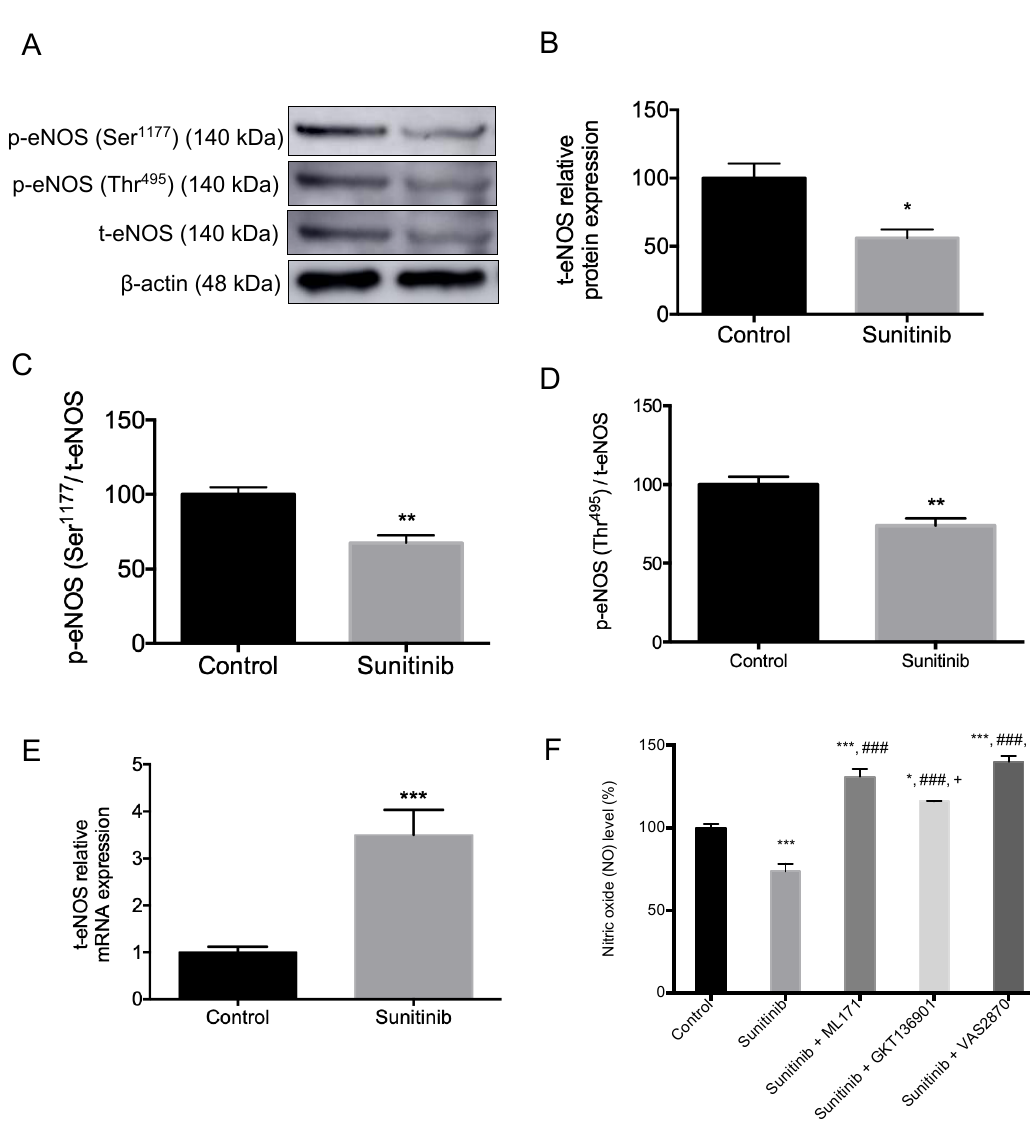
Figure 7. Protein expression of ( A ) p-endothelial nitric oxide synthase (eNOS) (Ser 1177 ) and p-eNOS (Thr 495 ); ( A , B ) total eNOS (t-eNOS); ( C ) ratio p-eNOS (Ser 1177 ) / total eNOS; ( D ) ratio p-eNOS (Thr 495 ) / total eNOS; ( E ) t-eNOS mRNA expression; and ( F ) NO levels in absence or presence of NOX inhibitors, in aortas from control and sunitinib-treated (25 mg / kg / day) animals. Values are expressed as mean ± S.E.M. of eight animals per group. * p < 0.05; ** p < 0.01; *** p < 0.001 vs. control group.; ### p < 0.001 vs. Su group; + p < 0.05 vs. Su + ML171 group; ºº p < 0.01 vs. Su + GKT136901